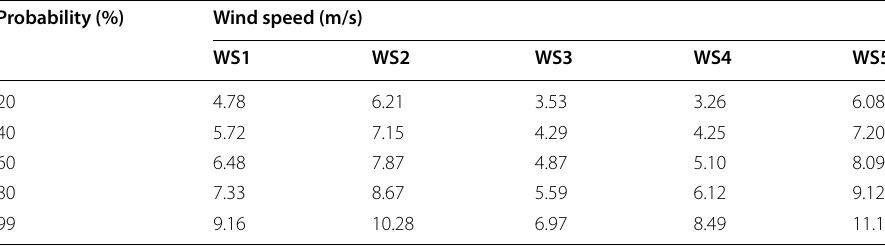
WS1 to 5 location of wind speed measurement =